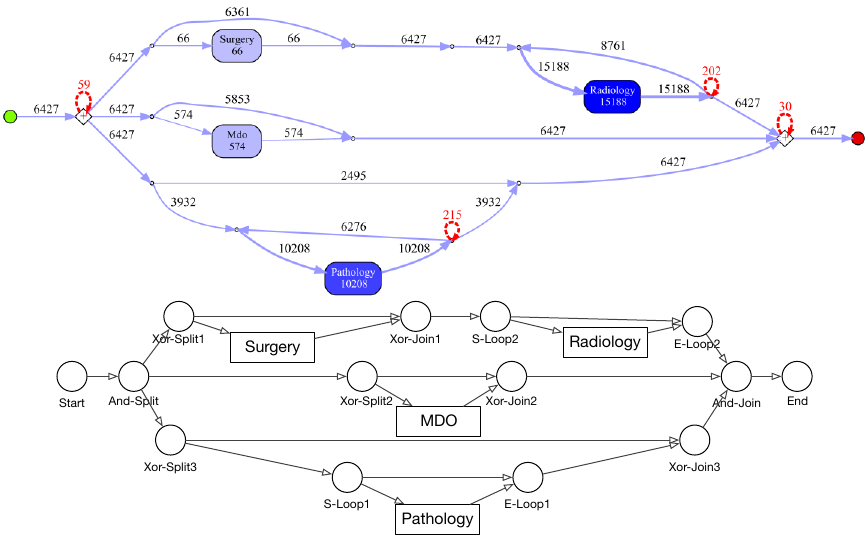
Figure 9. Process model for NoSVOB population (top) and derived directed graph (bottom). Edge weights and loops omitted in the graph for readability.